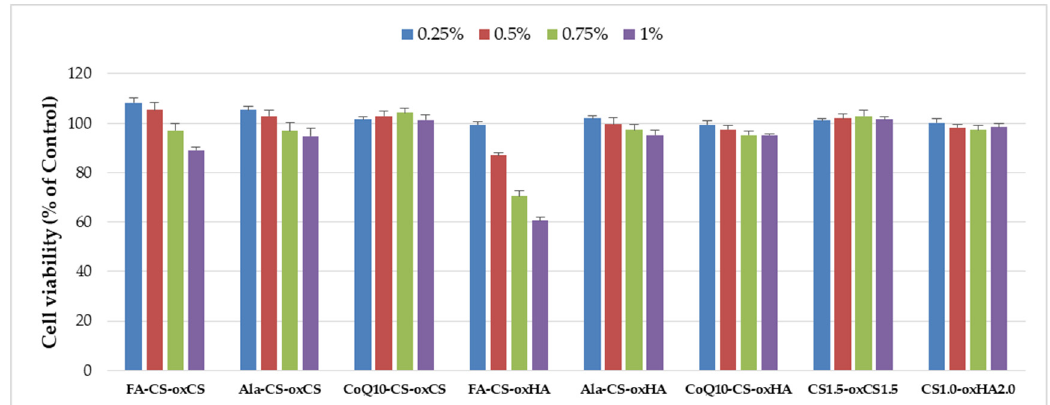
Figure 11. The cytotoxicity degree of CS-oxCS/oxHA and API-CS-oxCS/oxHA hydrogels.